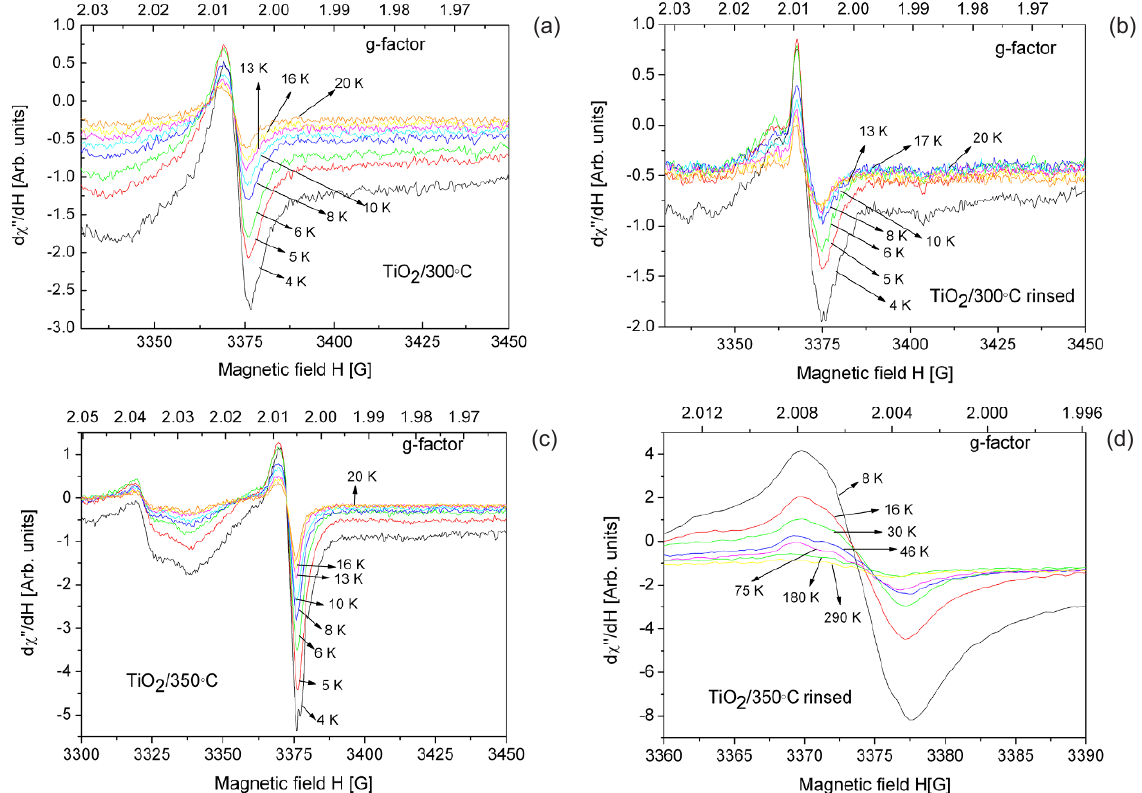
Figure 5. EPR spectra of OxR centers at different temperatures: (a) [TiO